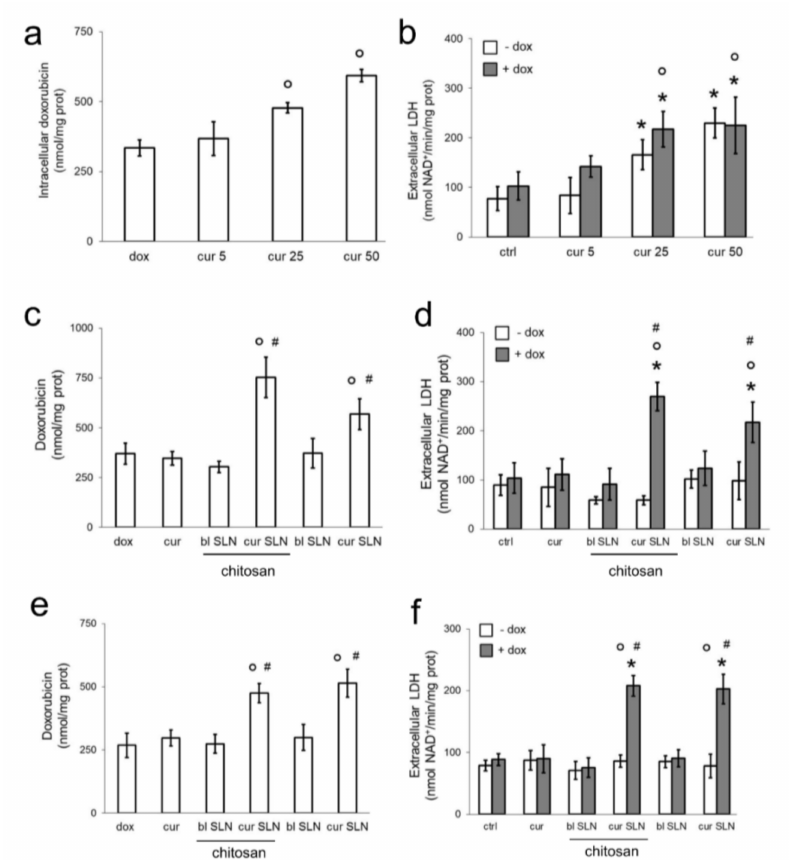
Figure 1. Dose-dependent e ff ects of free CURC and CURC-loaded SLNs on doxorubicin accumulation and cytotoxicity in MDA-MB-231 and JC cells. MDA-MB-231 (panels ( a – d )) and JC (panels ( e , f )) cells were incubated for 24 h with fresh medium (ctrl) or with the 5–25–50 µ M CURC (cur), in the absence ( − ) or presence ( + ) of 5 µ M doxorubicin (dox). ( a ) Intracellular doxorubicin was measured fluorimetrically in duplicates. Data are presented as means ± SD ( n = 3). ◦ p < 0.01: vs. dox. ( b ) The release of